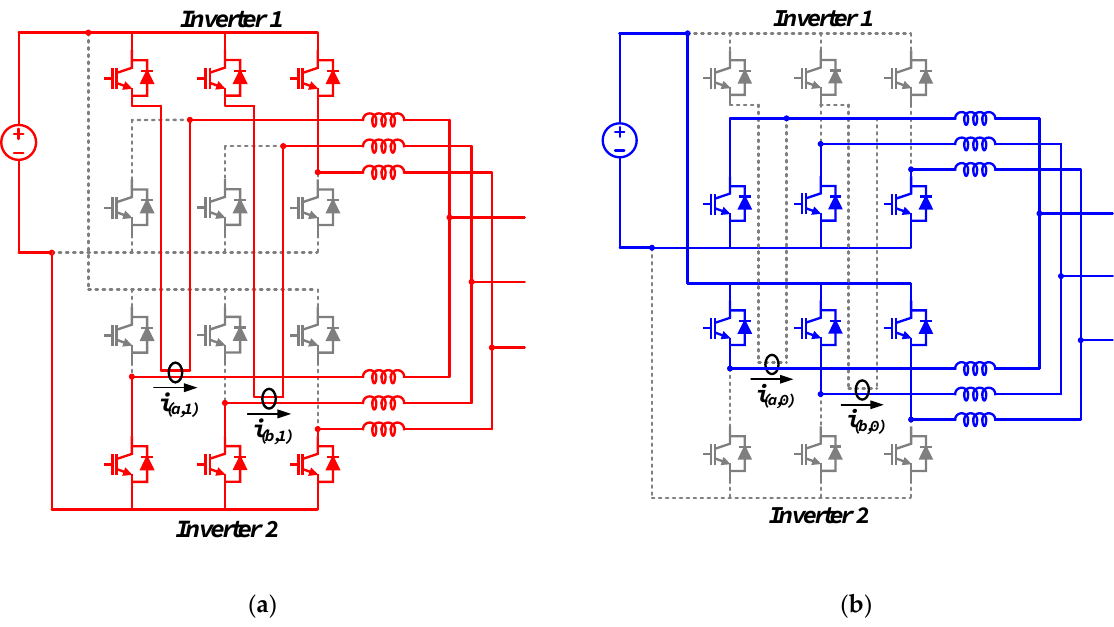
Figure 2. Current commutation path at the sampling points. ( a ) (Sa1, Sb1, Sc1) = (1, 1, 1). ( b ) (Sa1, Sb1, Sc1) = (0, 0, 0).